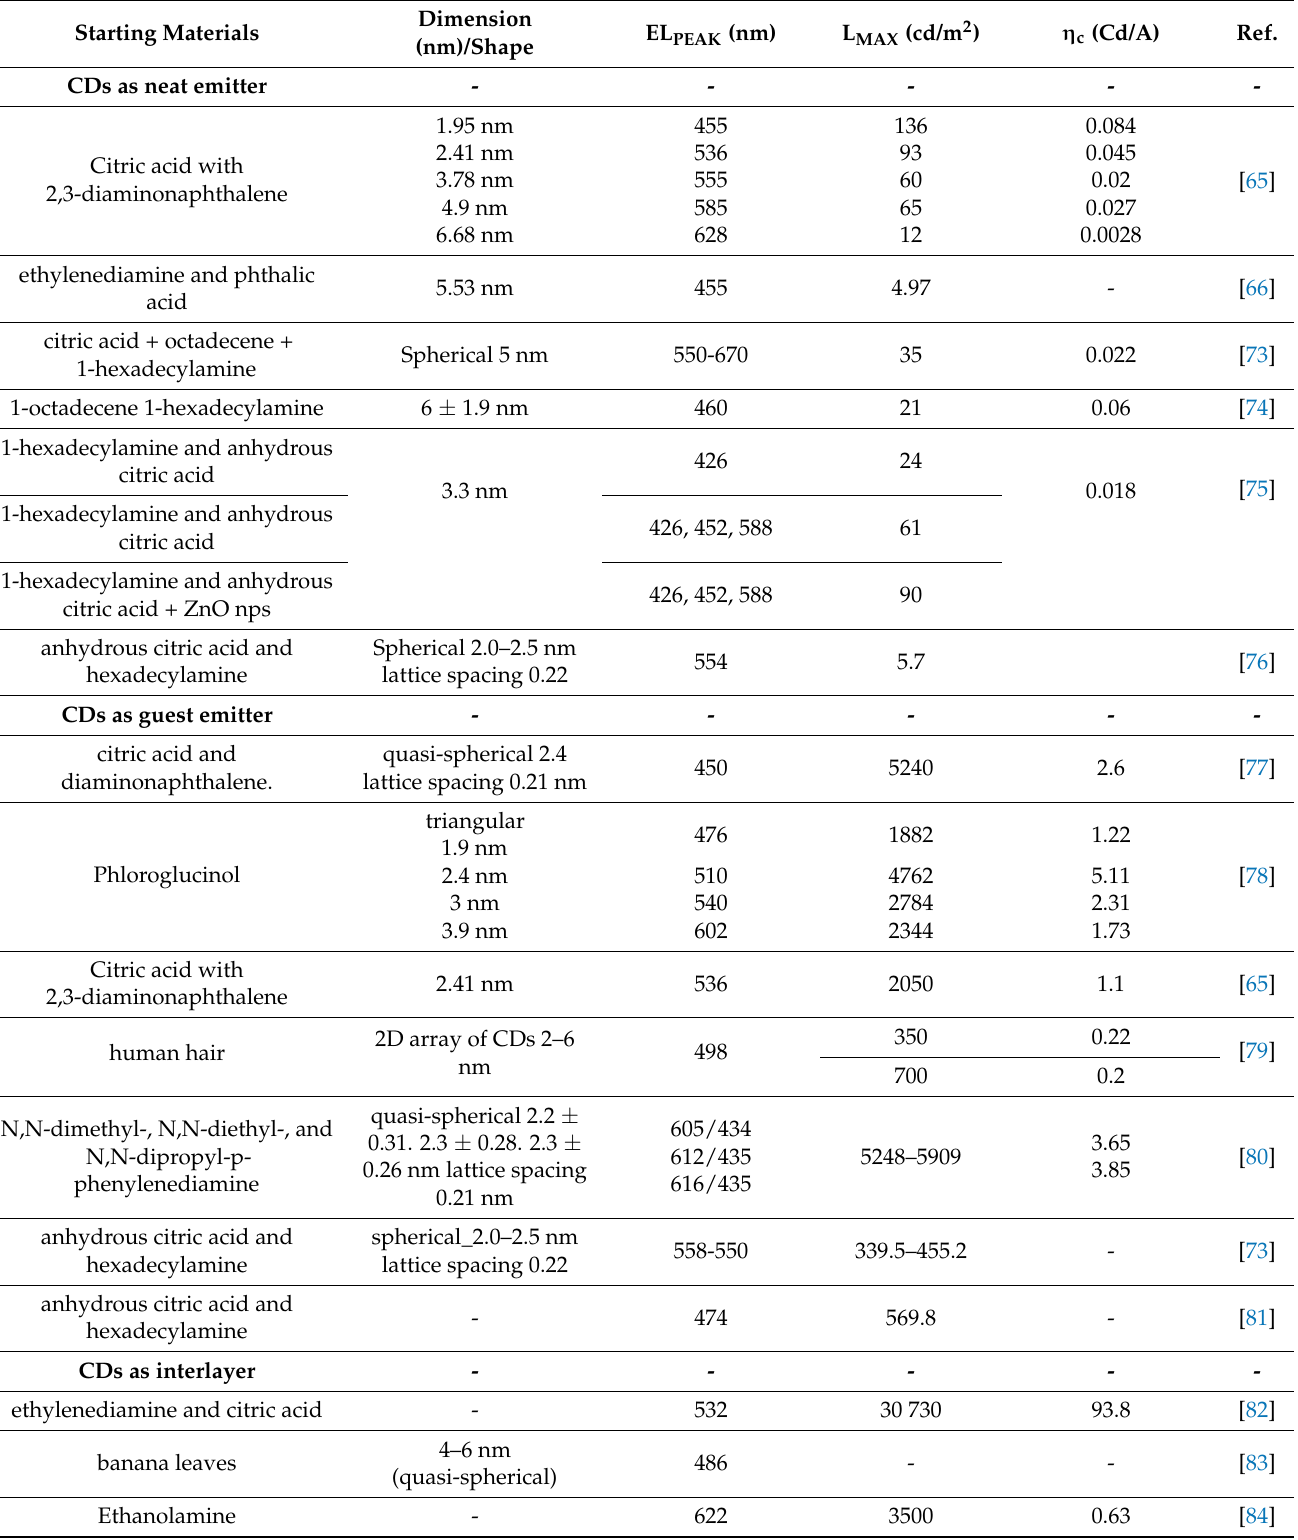
Table 1. Summary of organic light-emitting devices (OLEDs) incorporating a CD